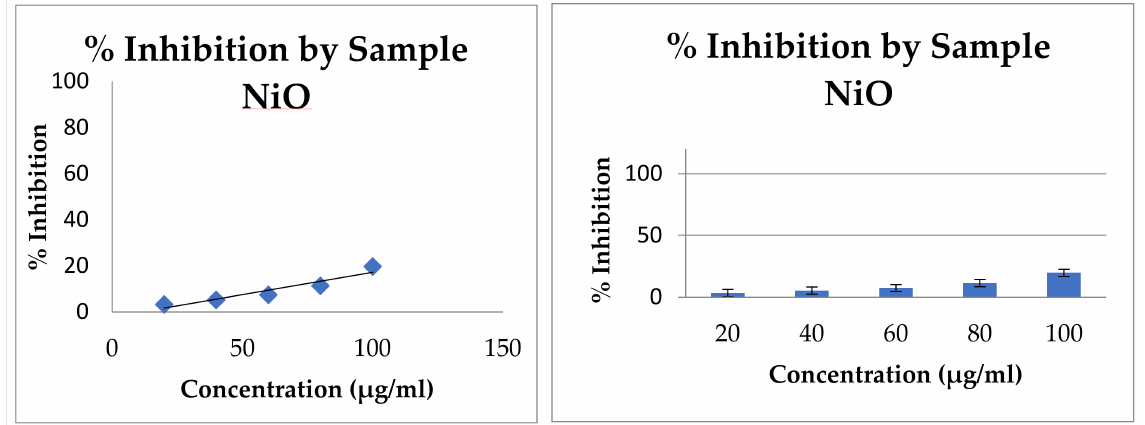
Figure 6. Antidiabetic potential of as-prepared NiO NPs showing inhibition of α -amylase activity at different